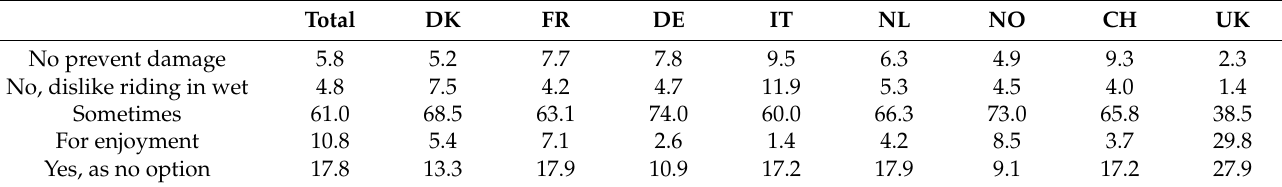
Table 5. Mountain bikers’ use of wet trails according to country